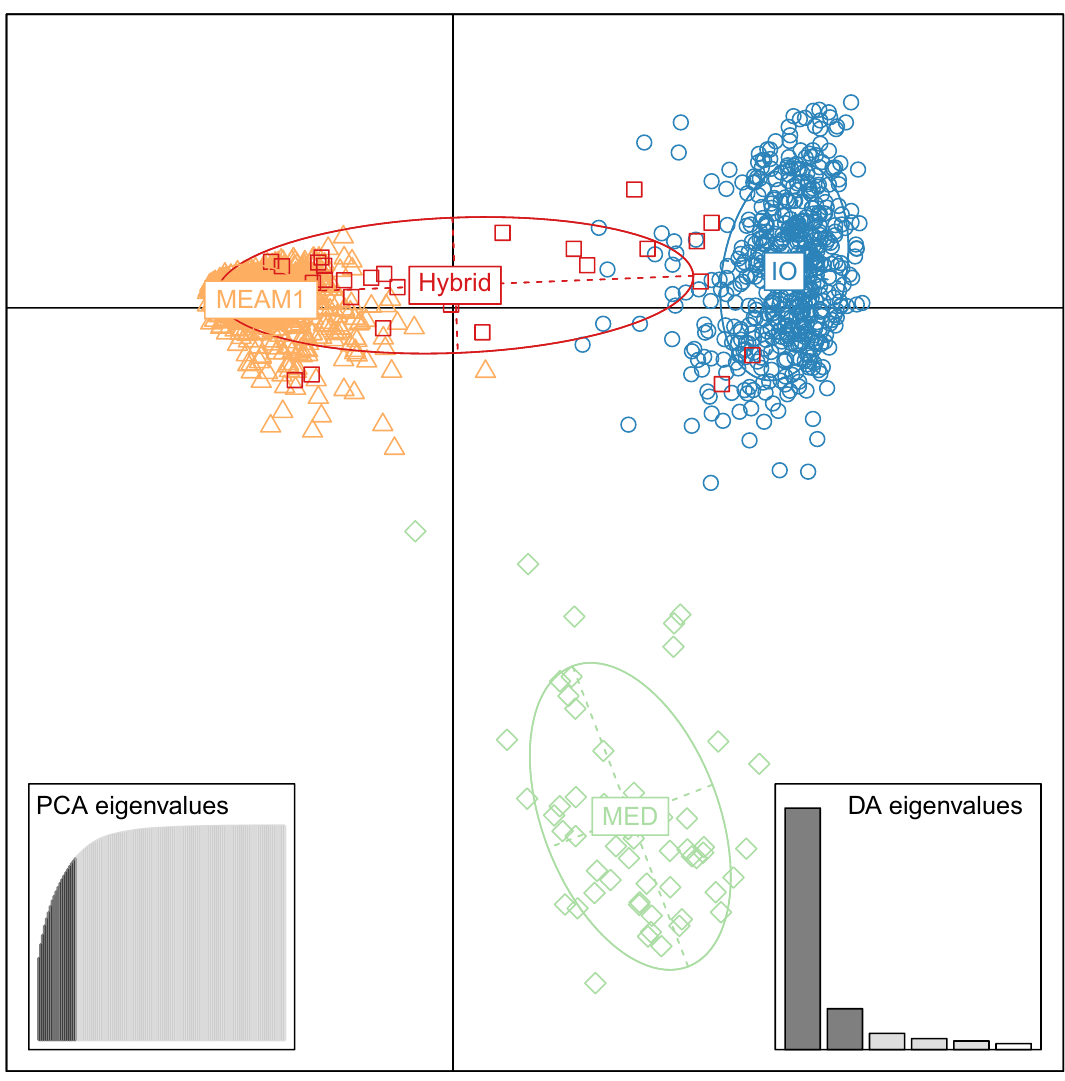
Figure 2. DAPC based on n = 1562 individuals using 11 microsatellite loci. Dots of different colours indicate individuals from different genetic clusters. PCs eigenvalues and discriminant factors retained are